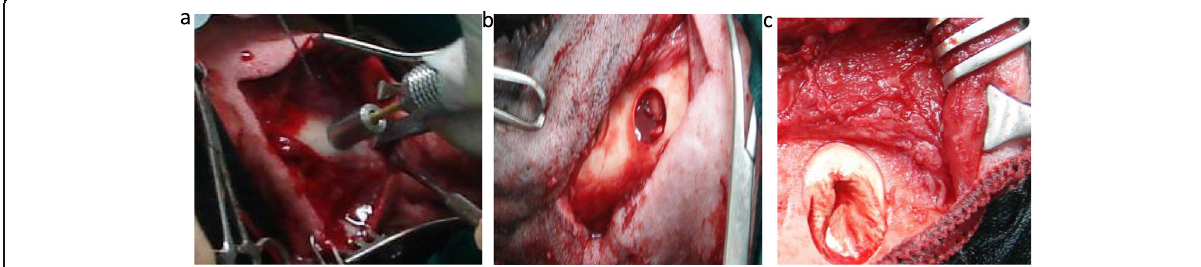
Fig. 1 a Trephine bur; 12 mm in diameter. b Surgically created bone defect after removal of the outer cortical plate. c The right (experimental) side obliterated with bony